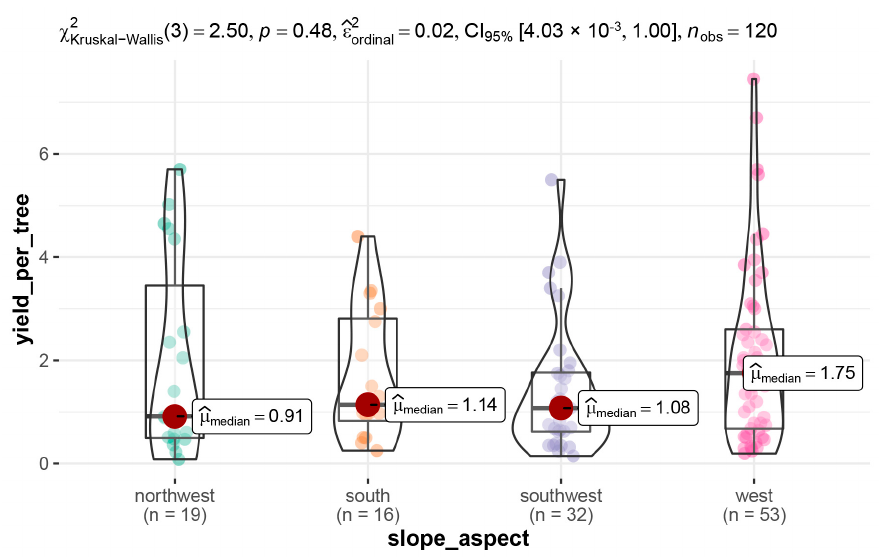
Figure A3. Comparison of green nut yield per tree (kg) among the different slope aspects (northwest, south, southwest, west). There is no significant difference among slope aspects ( p > 0.05).